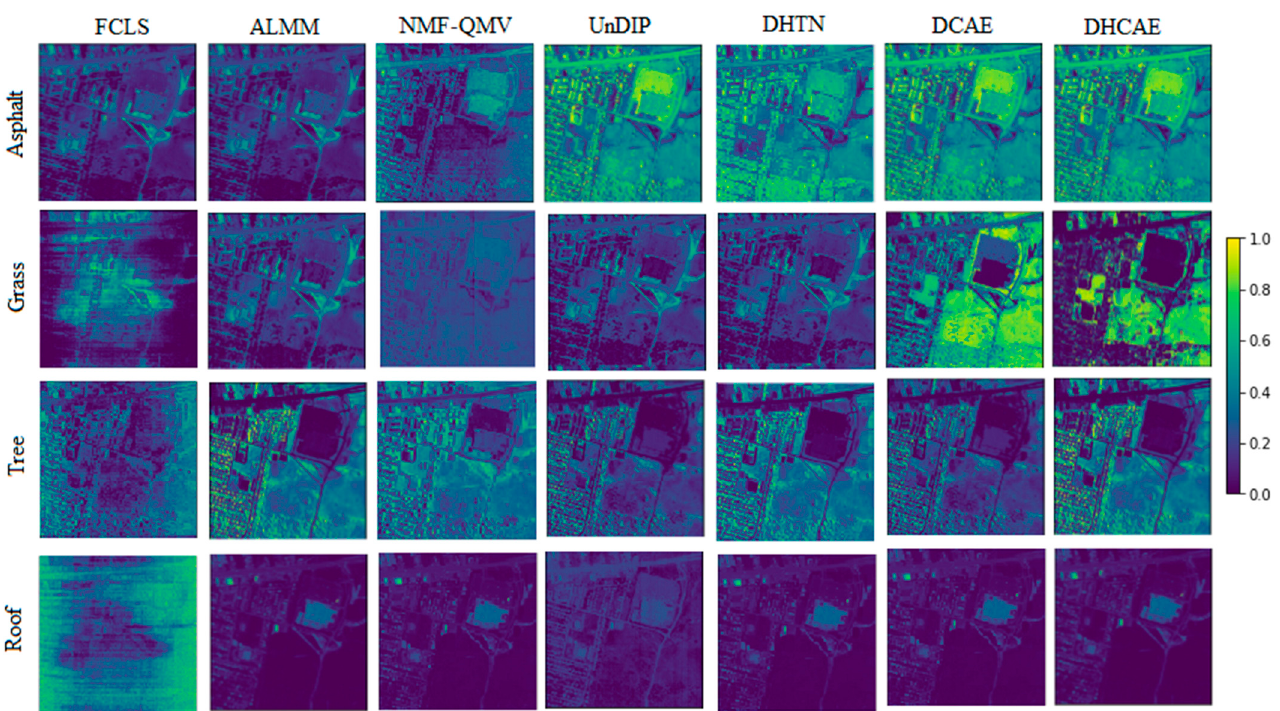
Figure 13. Urban data. Comparison of extracted abundance maps with noisy bands by different spectral unmixing methods.